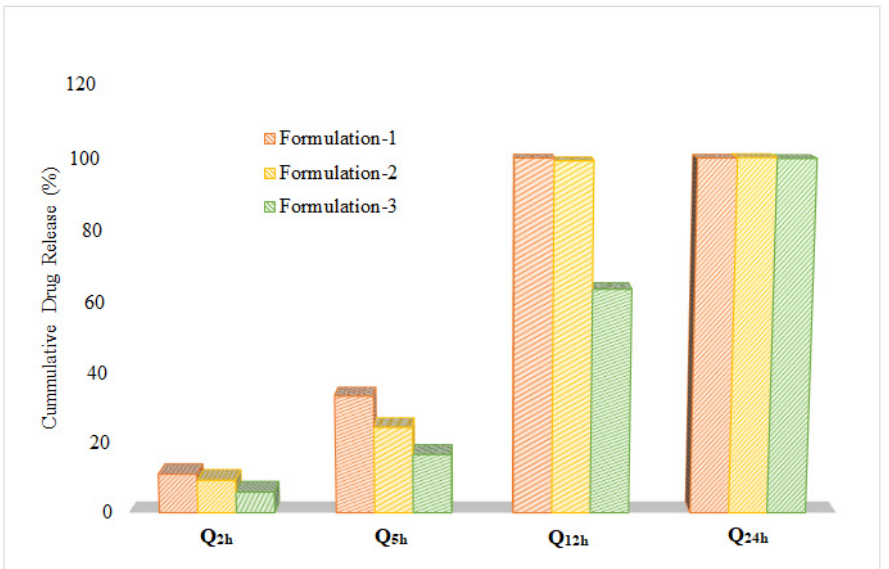
Figure 5. Comparison of quantity of drug release from polymeric matrix tablets of clarithromycin at different time intervals.